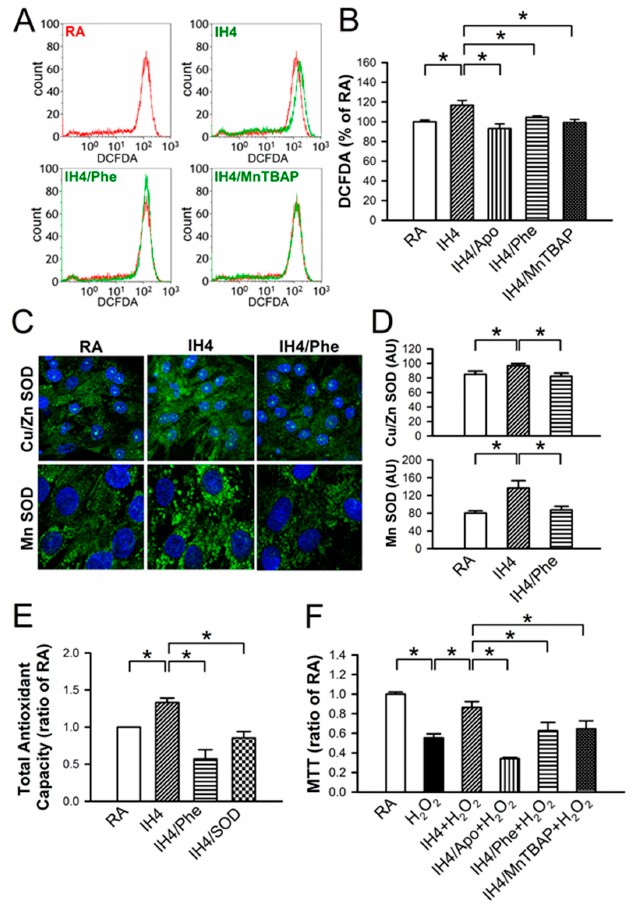
Figure 4. Involvement of ROS generation in the IH-increased antioxidant expression and cardioprotective effect. ( A ) The representative plots show the intracellular ROS change in various treatment measured by flow cytometry analysis using intracellular ROS probe, DCFDA. The result of cells treated with H 2 O 2 (30 μ M) in the RA was used as the positive control and shown with the red line, whereas treatment with IH4, IH4/Phe, or IH4/MnTBAP was shown with the green line. ( B ) The quantitative results show that the level of intracellular ROS was significantly higher in the cardiomyocytes treated with IH4 than with RA. However, co-treatment with an antioxidant, such as Apo, Phe, or MnTBAP, abolished the IH4-increased intracellular ROS level. Data represent the means ± SEM. RA: n = 10, IH4: n = 6, IH4/Apo: n = 6, IH4/Phe: n = 6, IH4/MnTBAP: n = 6. * p < 0.05. ( C ) The representative images show the expression of Cu/Zn SOD and MnSOD (green fluorescence) detected by immunocytofluorescence staining. The nucleus was stained by Hoechst 33342 (blue fluorescence). ( D ) The quantitative results show that the levels of Cu/Zn SOD and MnSOD were significantly higher in the cardiomyocytes treated with IH4 than with RA. However, co-treatment with Phe, an antioxidant, abolished the IH4-increased Cu/Zn SOD and MnSOD expression. Data represent the means ± SEM. ( n = 12). * p < 0.05. ( E ) The levels of TAC were significantly higher in the IH4-treated group than the RA-treated group. However, co-treatment with an antioxidant, Phe or SOD, abolished the IH4-increased TAC. Total antioxidant capacity as determined by assay kit. Data represent the means ± SEM. RA: n = 3, IH4: = 3, IH4 / Phe: n = 3, IH4 / SOD: n = 3. * p < 0.05 ( F ) Neonatal cardiomyocytes were treated with IH for four days, and then co-treated with IH and an antioxidant, Apo, Phe or MnTBAP, followed by 30 µ M H 2 O 2 treatment for 40 min. Treatment with IH4 prevented the H 2 O 2 -induced cell death. However, co-treatment with Apo, Phe or MnTBAP abolished the IH-prevented cell death. Data represent the means ± SEM. RA: n = 10, RA + H 2 O 2 : n = 10, IH4 + H 2 O 2 : n = 10, IH4 / Apo + H 2 O 2 : n = 4, IH4 / Phe + H 2 O 2 : n = 6, IH4 / MnTBAP + H 2 O 2 : n = 6. * p <